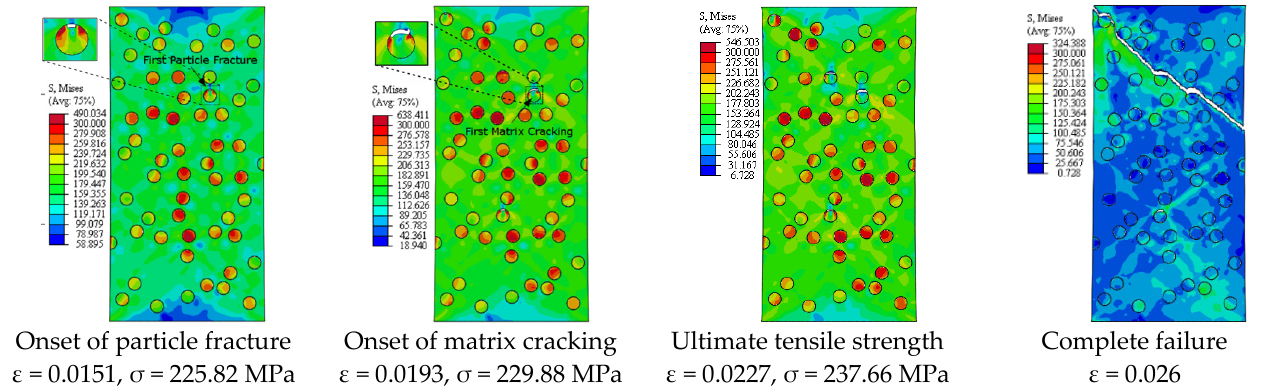
Figure 8. Failure propagation and von Mises stress distribution of A359/SiC composite at 10% VF (PS = 10 µm).